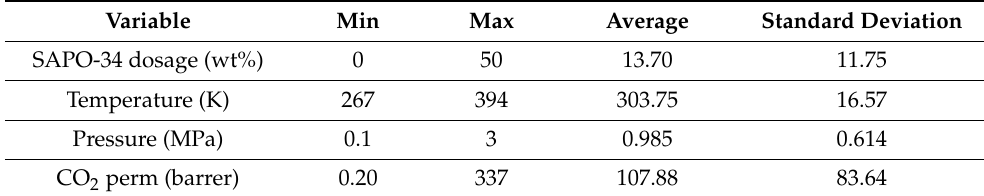
Table 1. Statistical information of the collected experimental databank